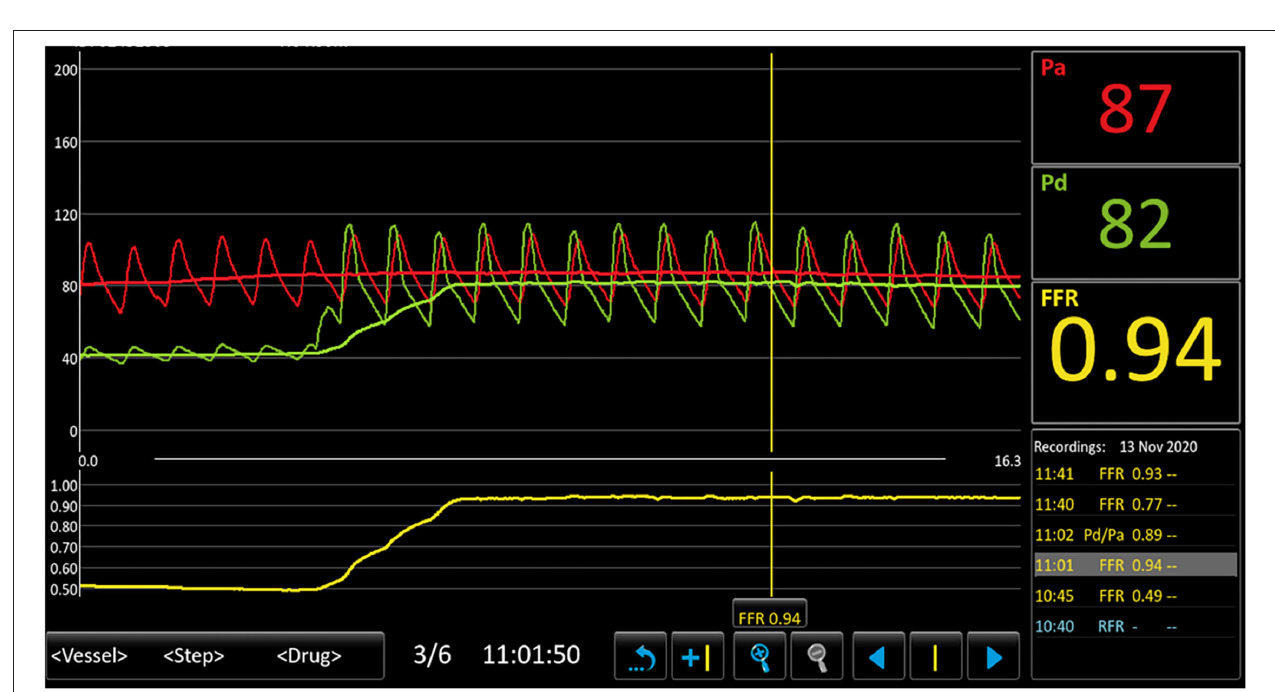
FIGURE 2 | Results of pressure guidewire measurement depicting Pa, Pd, and FFR before and after balloon angioplasty. This figure demonstrates a distal renal artery to proximal renal artery mean pressure gradient of 40mm Hg and the FFR was 0.49. A significant increase in Pd was found after the pullback of the guidewire. Pa, mean aortic pressure; Pd, pressure distal to the stenosis; FFR, fractional flow